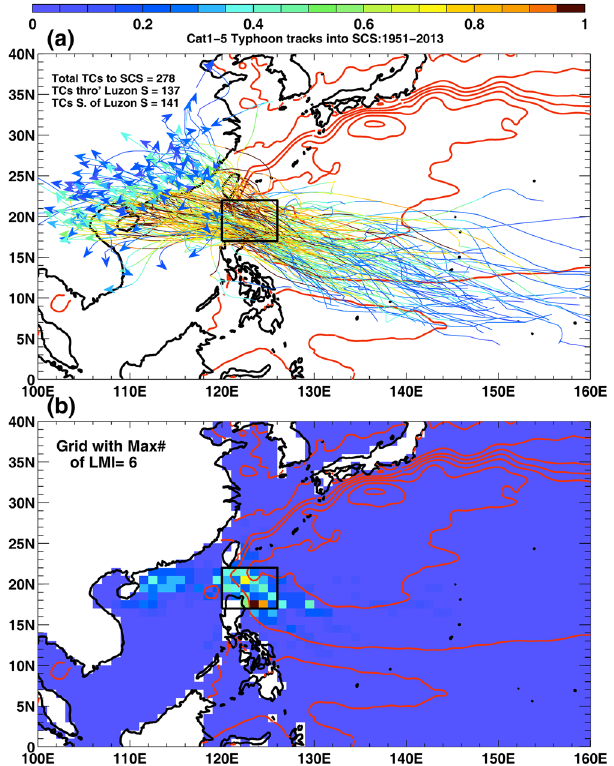
Figure 1. ( a ) Tracks of typhoons from western Pacific into SCS through the Luzon Strait, from 1951–2013, updated from Sun and Oey 1 using the latest IBTrACS observations. For each track, colors show 6-hourly wind speeds normalized by the maximum wind speed for that track; darkest brown color corresponds to normalized wind speeds > 0.95, and indicates where and when the typhoon was near its LMI. Top left shows the total TCs into SCS (278), subdivided into those passing through the Luzon Strait (i.e. the LSTCs, 137), and south of the strait (141, tracks not shown). Red contours show mean absolute dynamic topography MADT ( m ) from AVISO http://www.aviso.oceanobs.com/. ( b ) The number of LMIs per 1 o × 1 o grid (normalized by the maximum number = 6), according to tracks in ( a ). Tracks within 50 km of the northern (southern) tip of Luzon (Taiwan) were excluded. Maps plotted using MATLAB Version#R2012a (7.14.0.739) 64-bit (glnxa64) (https://www.